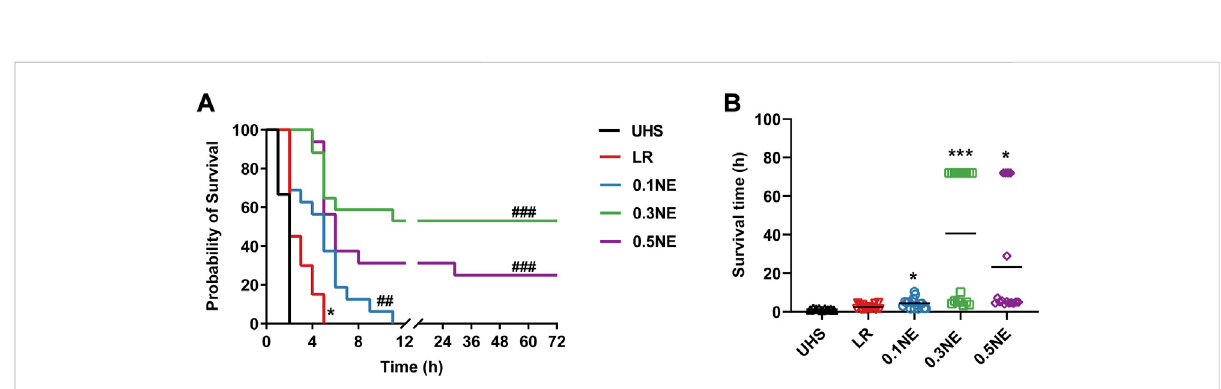
FIGURE 9 The effect of on survival outcome following 1 h of hypotensive resuscitation. (A) 72 h survival rate. * p < 0.05 as compared with the UHS group. ## p < 0.01, ### p < 0.001 as compared with the LR group. (B) the avrage survival time. * p < 0.05, *** p < 0.001 as compared with the LR group.